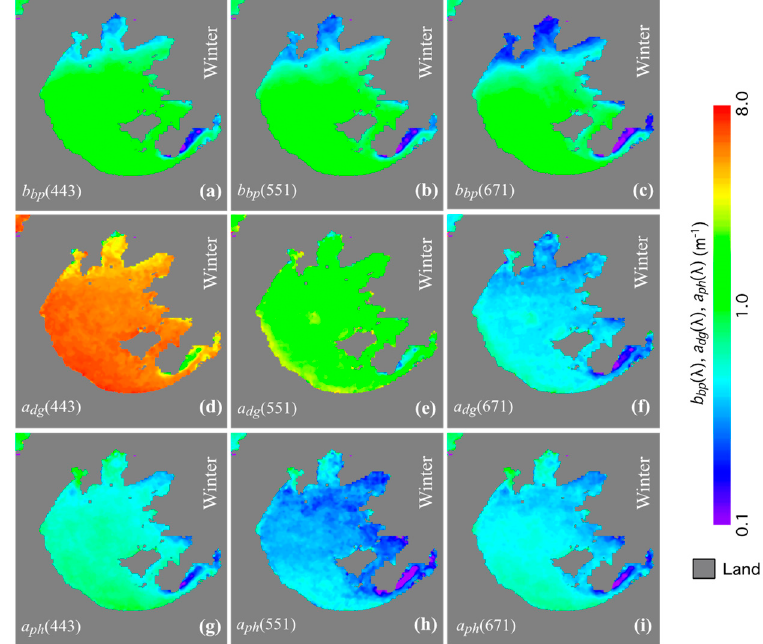
Figure 9. VIIRS-derived IOP in Lake Taihu during the winter season between 2012 and 2018 for ( a – c ) b bp ( λ ), ( d – f ) a dg ( λ ), and ( g – i ) a ph ( λ ) at the VIIRS bands of 443 nm (left column), 551 nm (middle column), and 671 nm (right column).